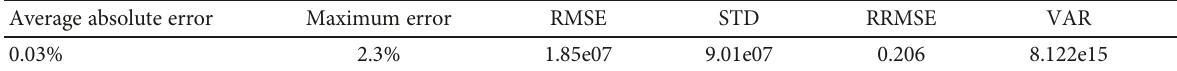
Table 2: Analysis of variance results (ANOVA).